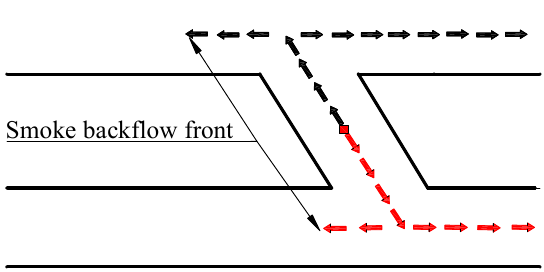
Figure 14. Schematic diagram of smoke backflow.